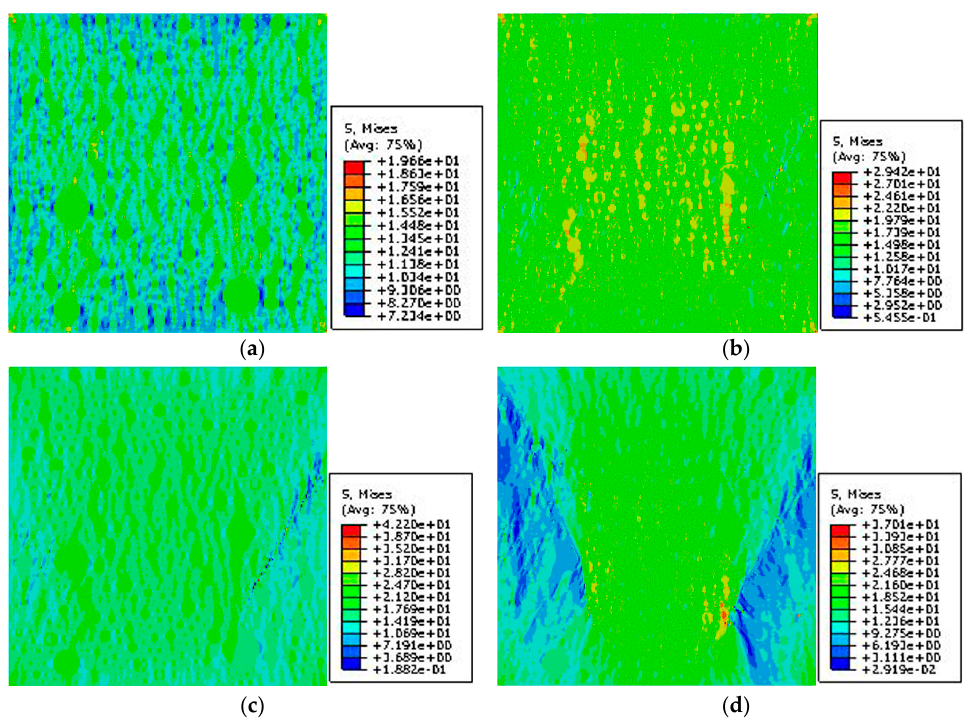
Figure 13. Stress nephogram of 2D RCA model for mortar (M1) with different strains: ( a ) ε = 0.03%; ( b ) ε = 0.1%; ( c ) ε = 0.3%; ( d ) ε = 0.45%.